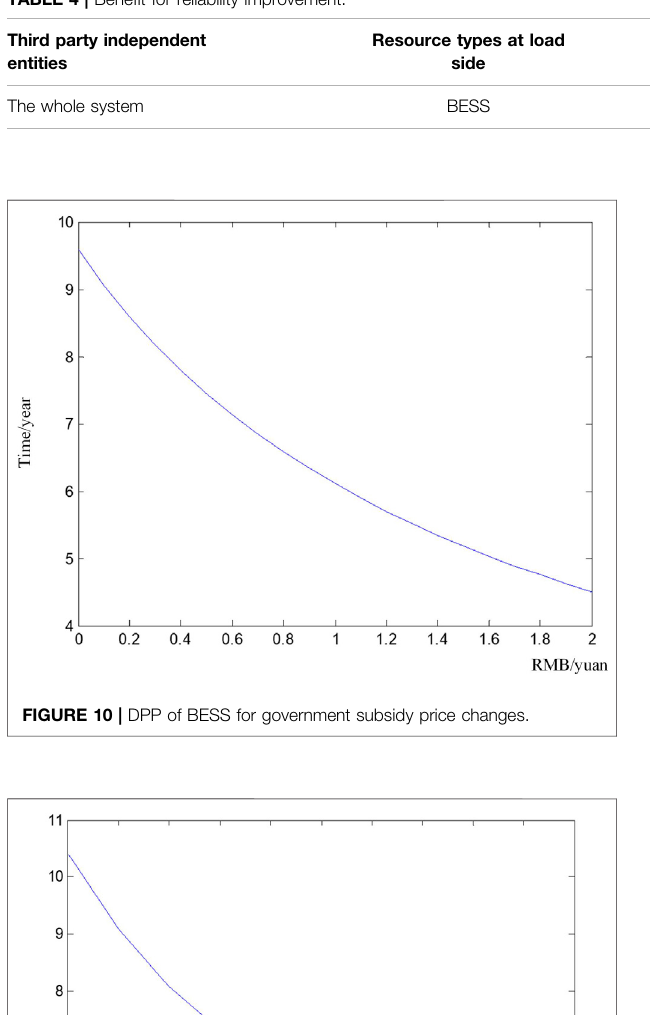
Frontiers in Energy Research |